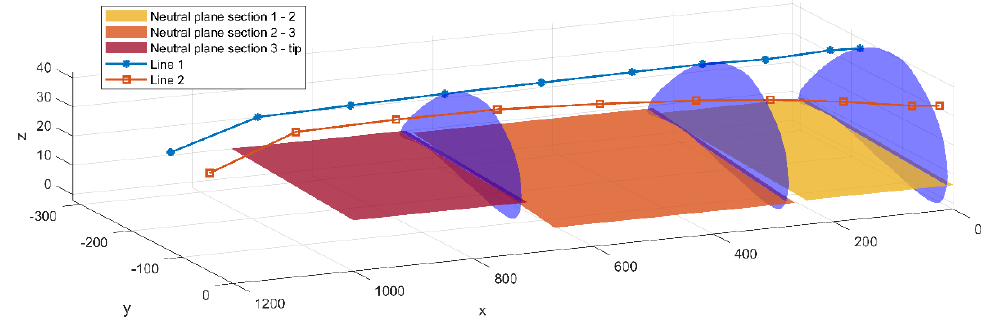
Figure 8. Neutral planes and measuring lines for Ko’s Displacement Theory. Cross-sections consid- ered for neutral axis calculation are represented in purple color.